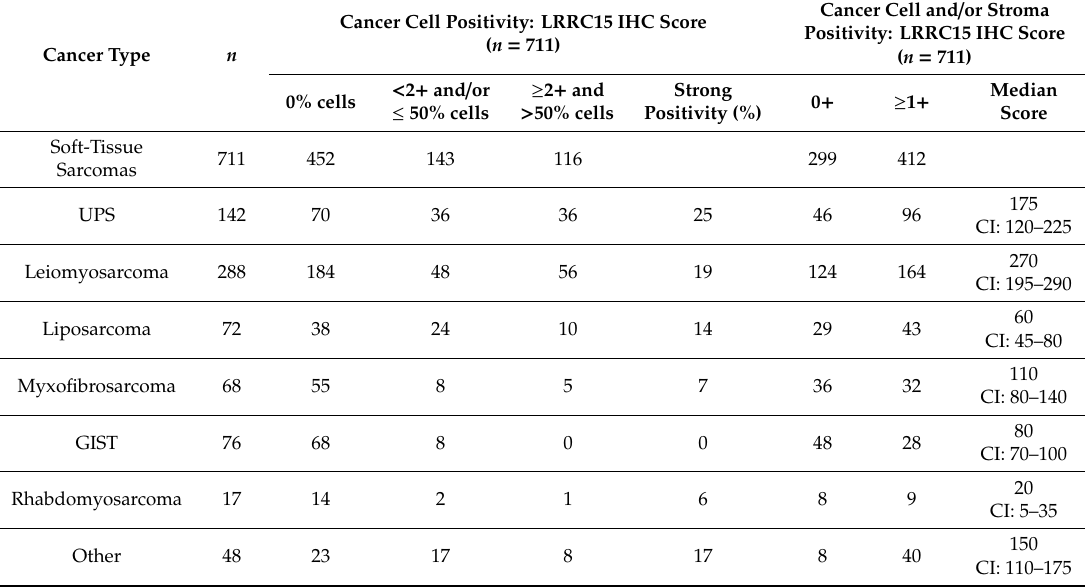
Table 1. LRRC15 expression in soft-tissue sarcoma.